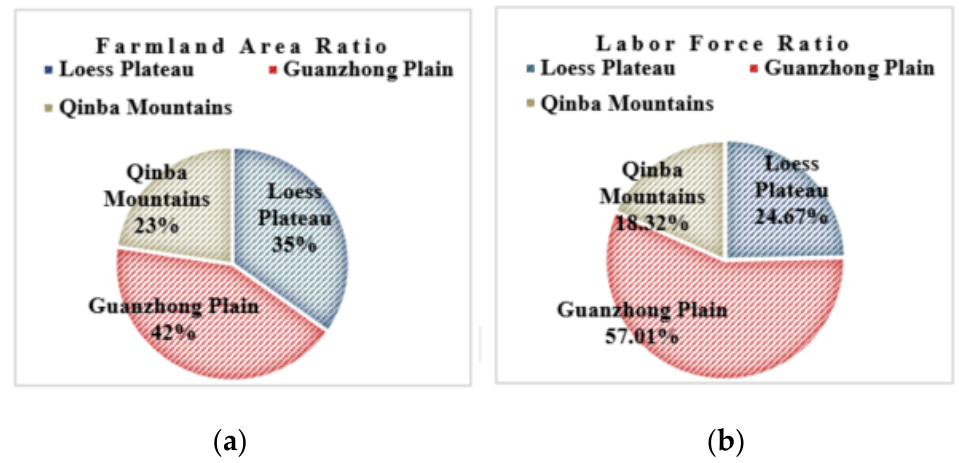
Figure 2. ( a ) Farmland distribution in Shaanxi Province; ( b ) labor force distribution in Shaanxi Province.